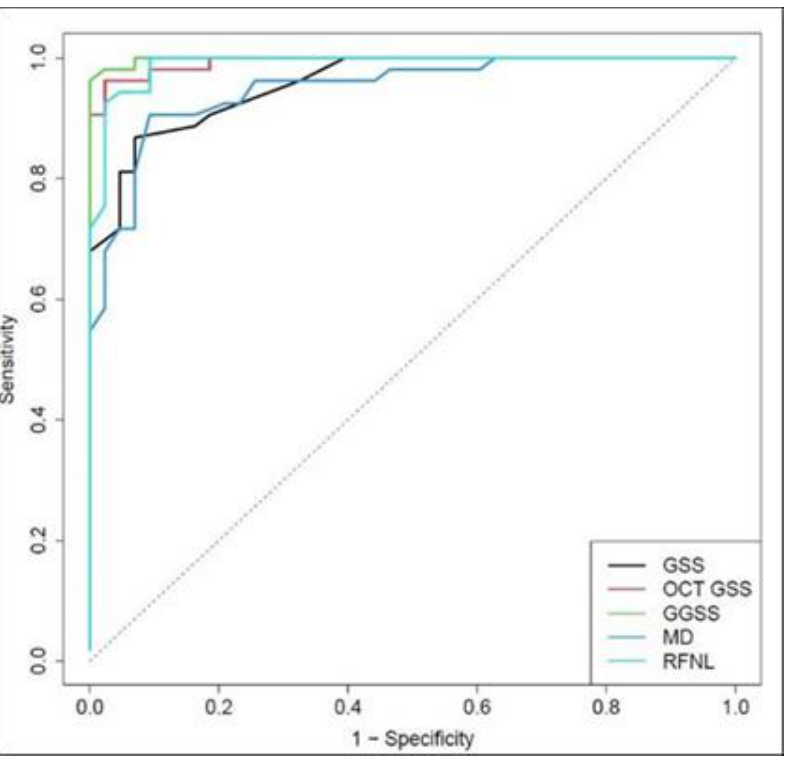
Figure 4. ROC curves for GGSS and the other methods used to classify the 53 early glaucoma